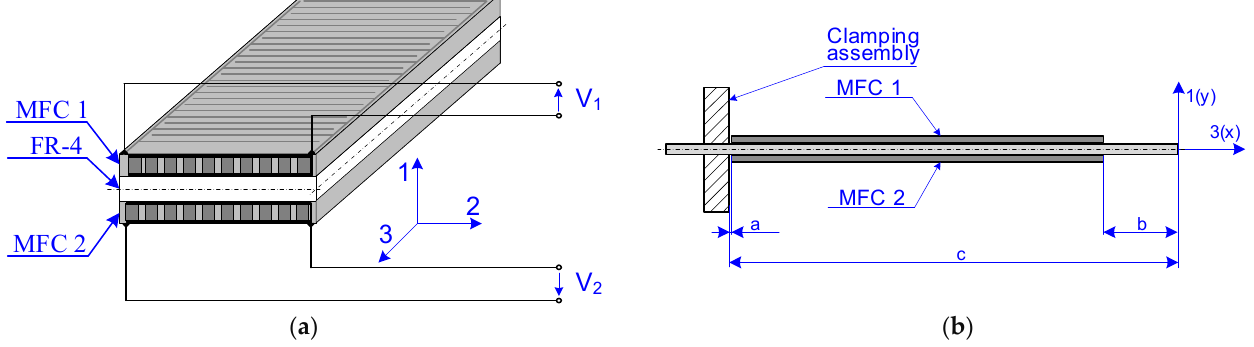
Figure 1. Piezoelectric bimorph actuator: ( a ) structure: V 1 —control voltage for MFC patch 1, V 2 —control voltage for MFC patch 2; ( b ) fixing in a clamping assembly: a—distance between MFC patches and clamping assembly, b—distance between MFC patches and beam tip, c—distance between clamping assembly and beam tip. Table 1. Dimensions of manufactured cantilever ‐ type bimorph actuator (values in mm). Dimension Value Length of MFC